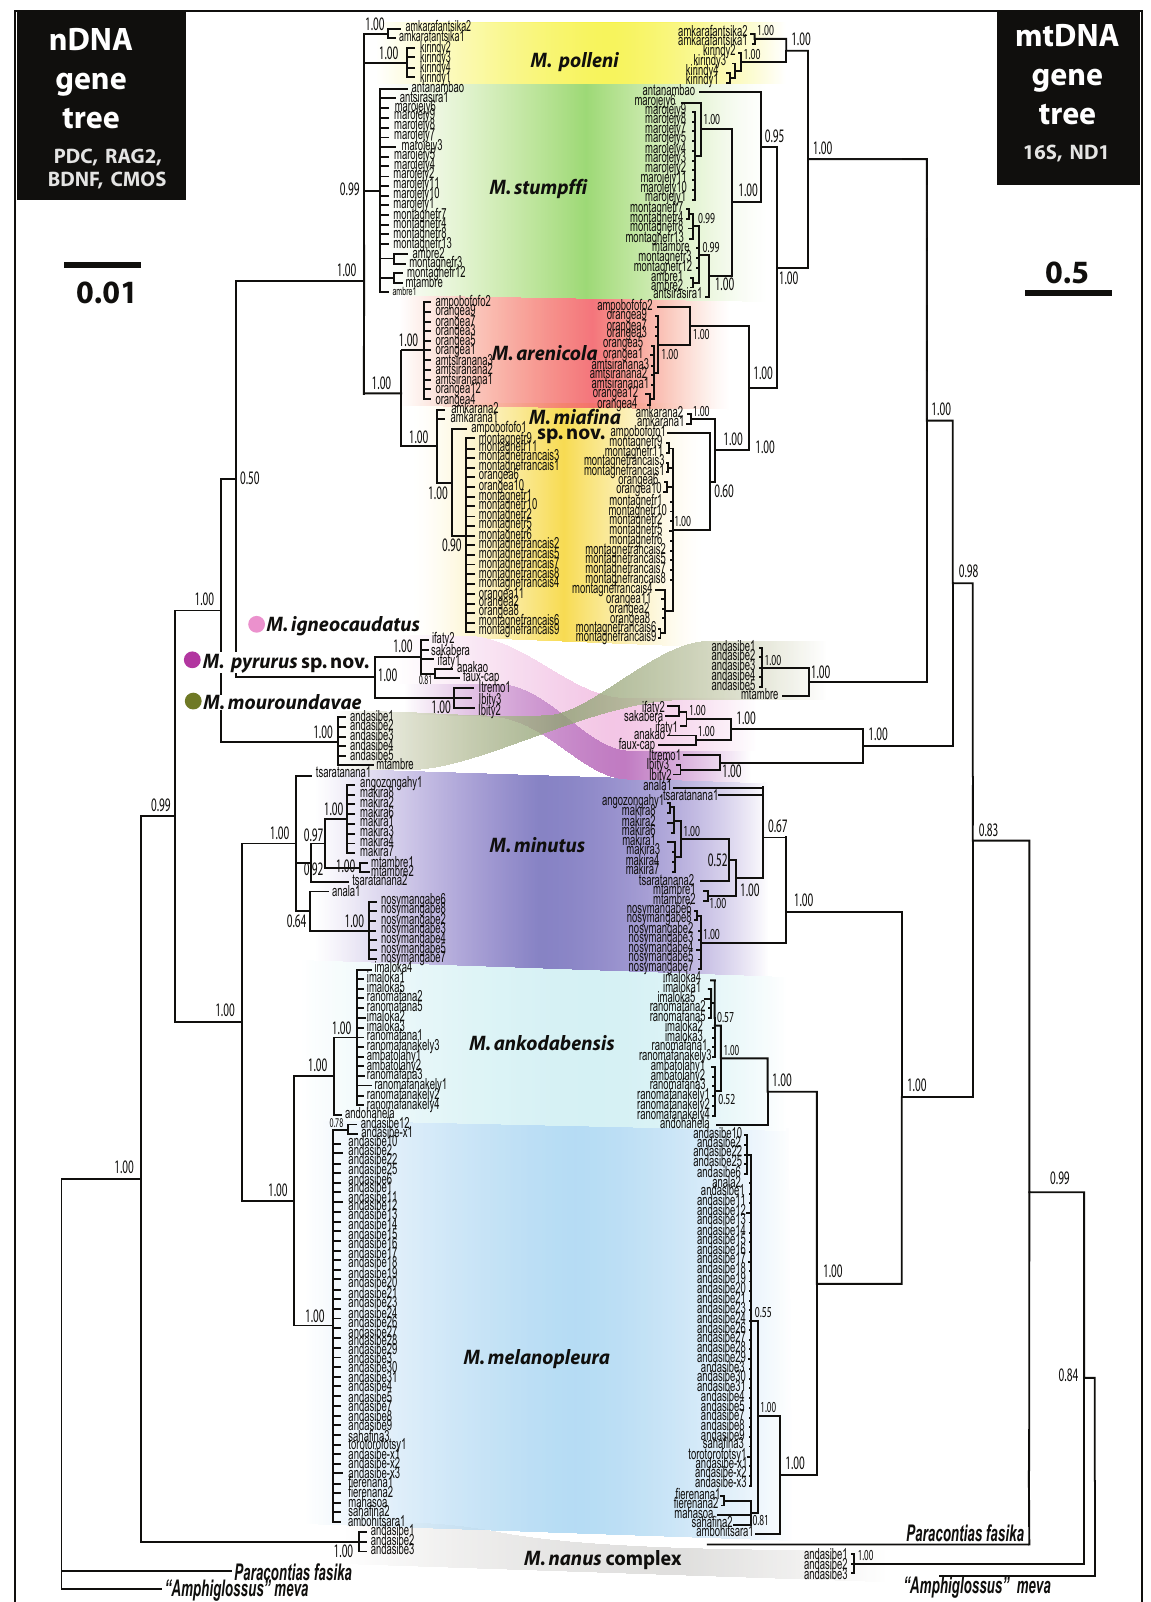
Figure 1. Comparison of phylogenetic trees of the genus Madascincus based on nDNA and mtDNA sequences (modified from Mi - ralles and Vences 2013). Nuclear DNA tree inferred from BI analysis of concatenated BDNF, CMOS, PDC and RAG2 sequences compared to the mitochondrial DNA inferred from ND1and 16S sequences (unpartitioned data set, posterior probabilities indicated for each node, see Miralles and Vences 2013 for details of analysis